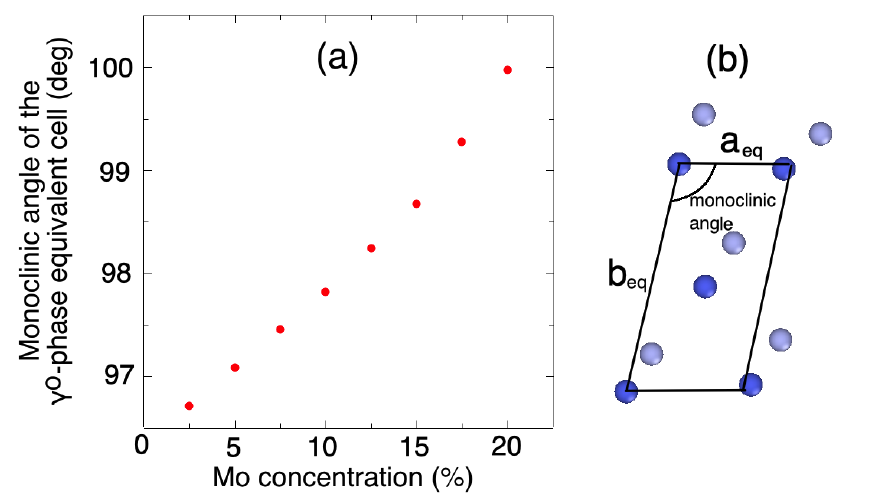
Figure 3. ( a ) The monoclinic angle of an equivalent cell of γ 0 -phase at room temperature (for various Mo concentrations). ( b ) Projection of atomic positions in the γ 0 -phase equivalent unit cell onto its [ 110 ] plane. Blue atoms correspond to the z = 0 plane and light blue atoms to the z = 0.5 c eq